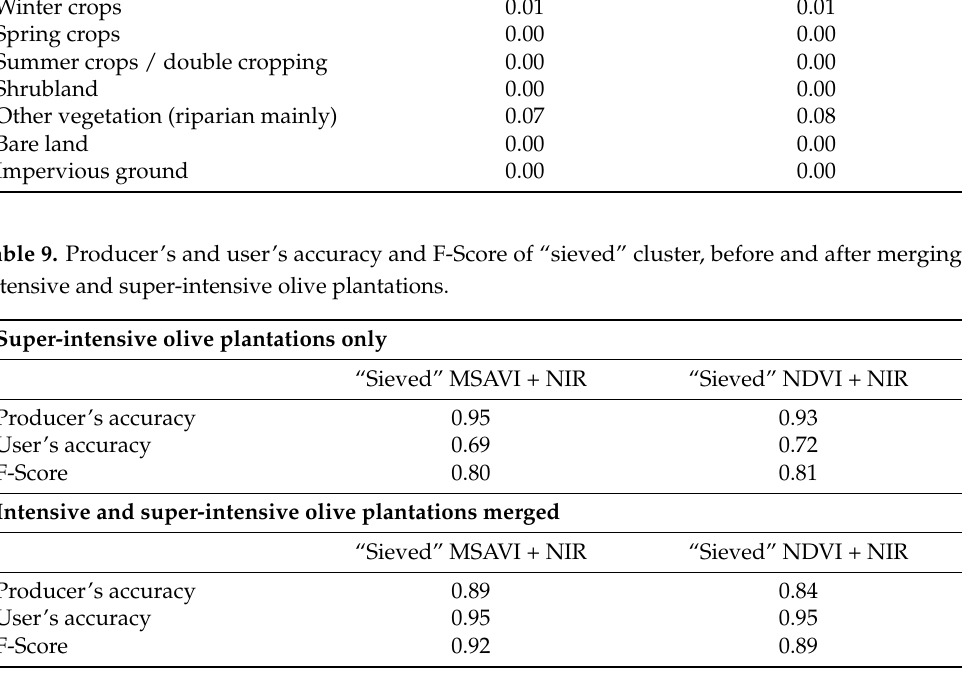
Table 8. Commission errors after “sieving” at a 500-pixel threshold using NDVI and MSAVI-2.